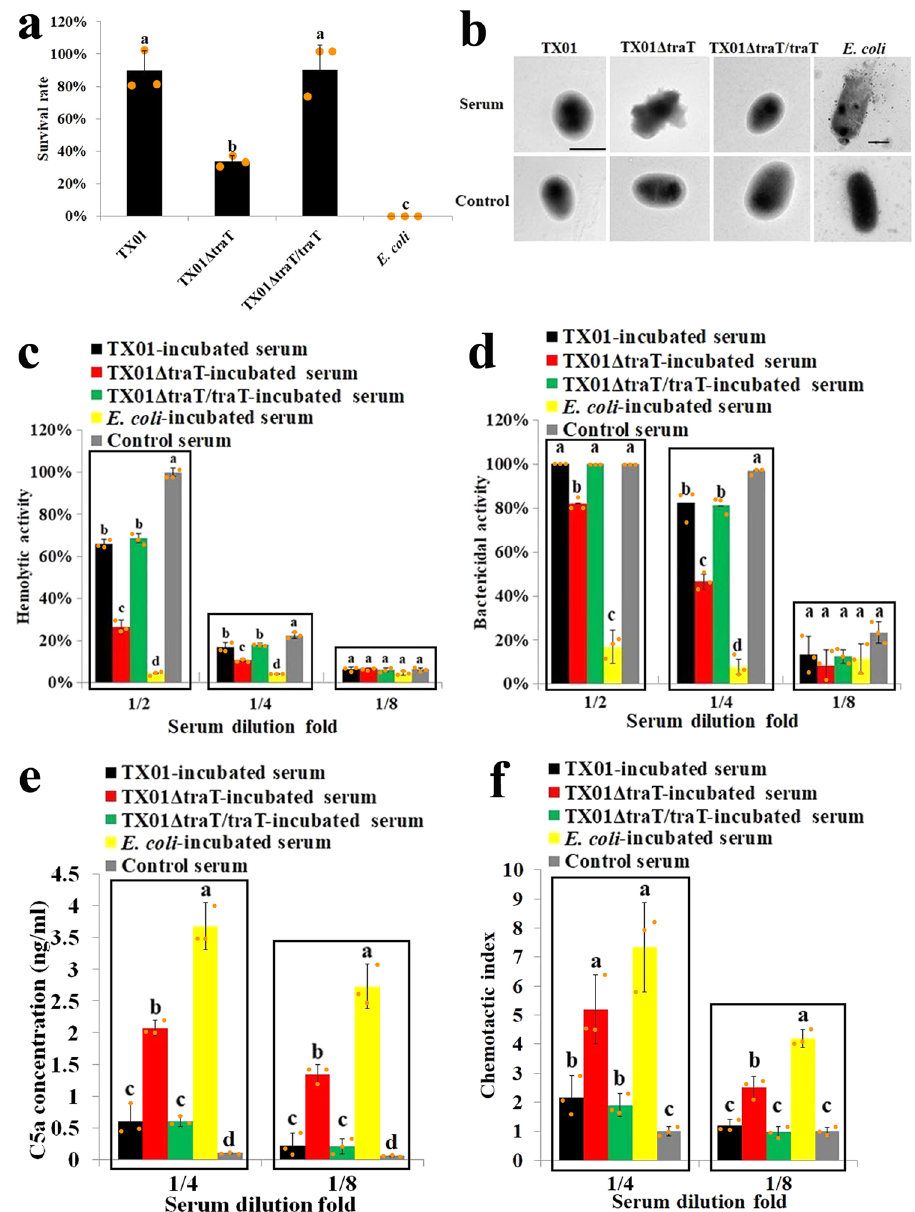
Fig. 1 Edwardsiella tarda TraT is essential to serum resistance and complement activation. a E. tarda wild type (TX01), traT mutant (TX01 Δ traT), and traT complement (TX01 Δ traT/traT) strains were treated with serum for 1 h, and bacterial survival was then determined. Escherichia coli was included for comparison. Different letters indicate statistical signi fi cance among the samples, P < 0.05. b E. tarda variants and E. coli were treated with or without (control) serum as above and subjected to transmission electron microscopy. Bar, 1 μ m. c – f E. tarda variants and E. coli were incubated with diluted serum for 1 h. The hemolytic activity ( c ), bactericidal activity ( d ), C5a concentration ( e ), and chemotactic activity ( f ) in the serum were determined. In all panels except ( b ), data are the means of three experiments and shown as means ± SEM. For panels c , d , e , and f , in each serum dilution, different letters indicate statistical signi fi cance among the samples, P <